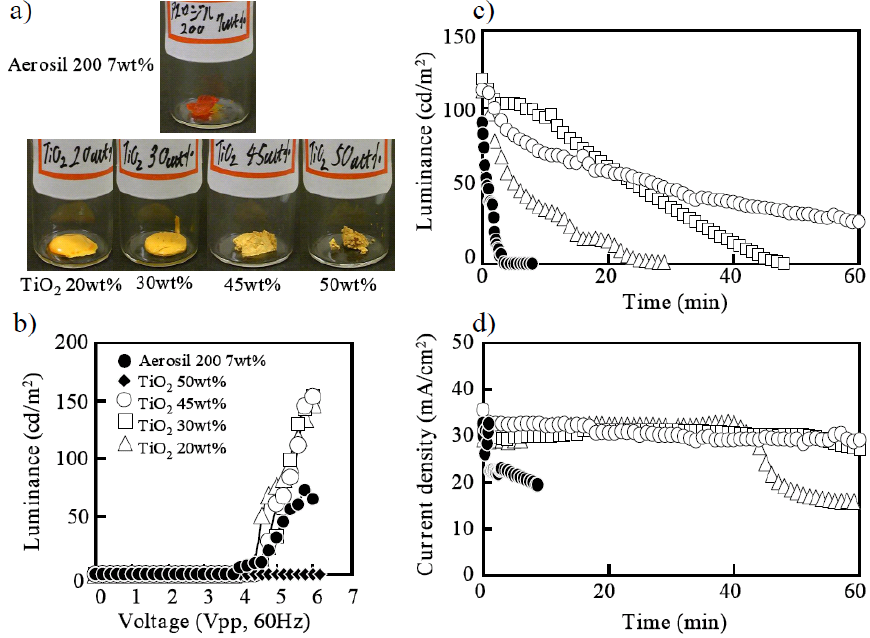
Figure 4. (a) Photographs of ECL gels solidified by silica and TiO for explanation of figure. (b) Characteristics of luminance of voltage applied to ECL